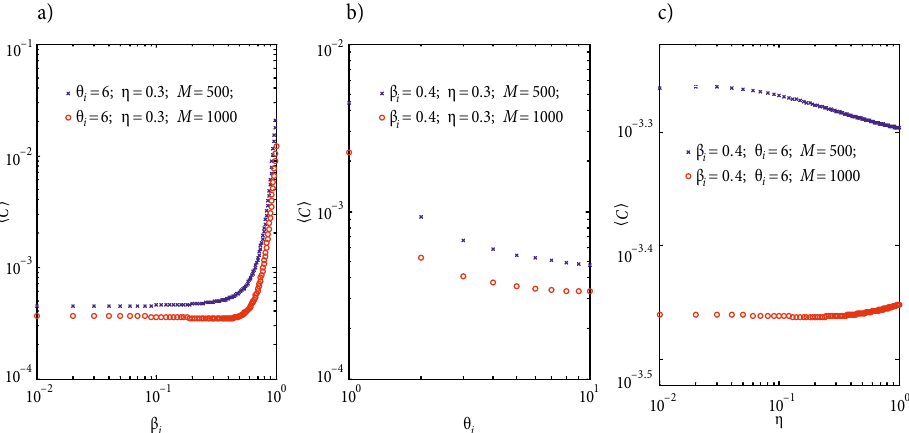
Fig. 7. The average clustering coefficient C of the network of credit risk contagion as a function of (a) the average fitness h of credit risk contagion in the network, (b) the risk aversion sentiments b i of node i on credit risk contagion, and (c) the resistance q of node i on credit risk contagion, i for the network size M = 500 and M = 1000